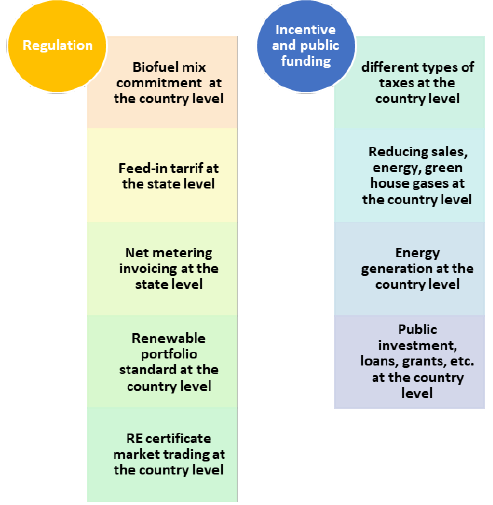
Figure 1. Indian policies and incentives.